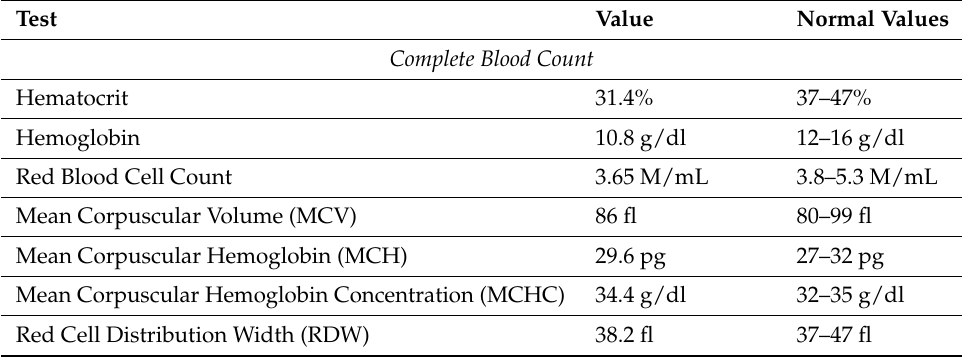
Table 1. Patient’s laboratory